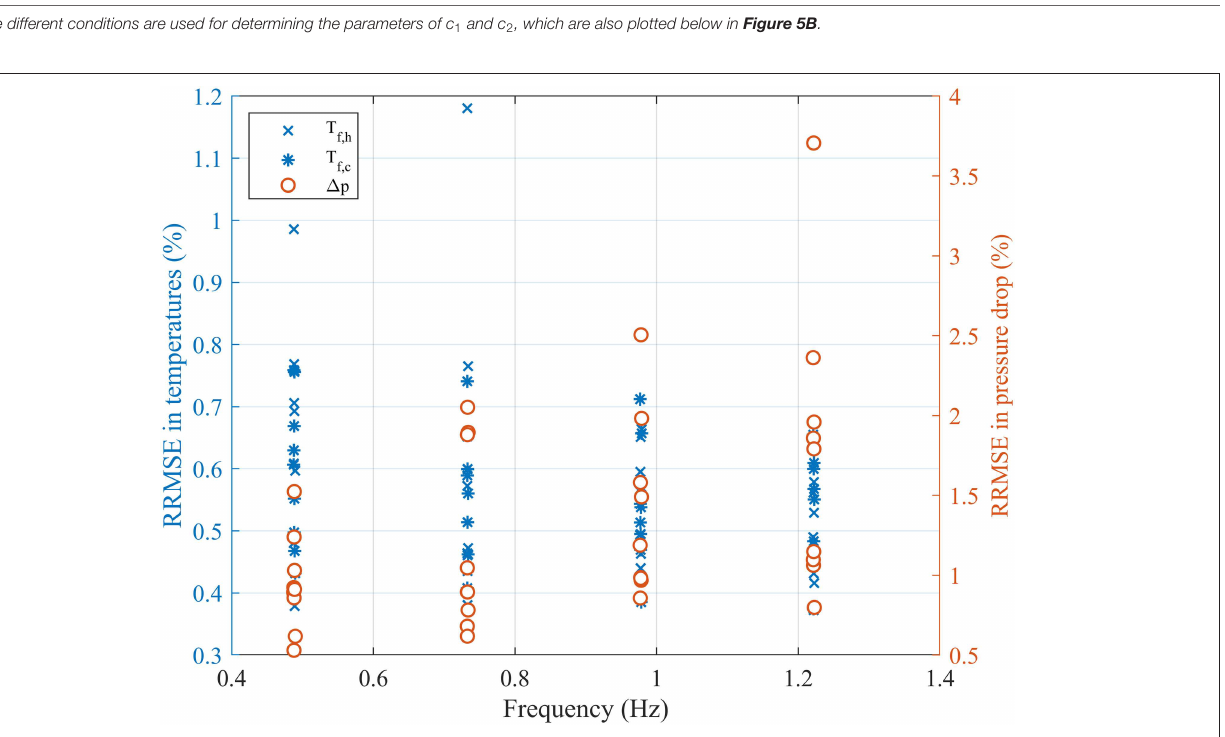
FIGURE 4 | Experimental and fit comparisons of relationships of RMSE distributions for regenerators #1, #2 and